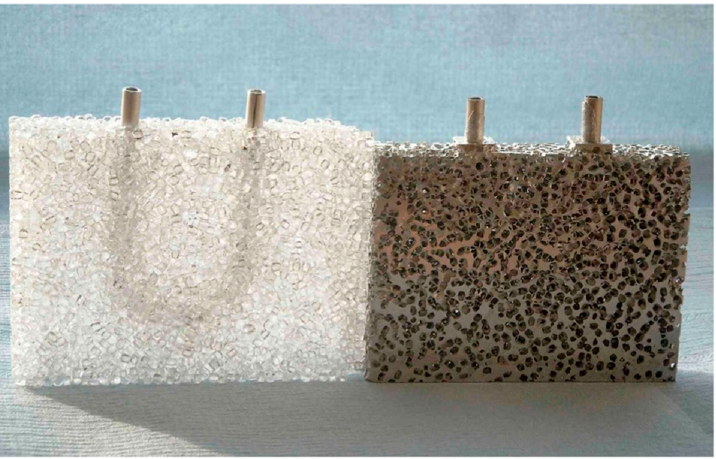
Figure 5. Use of supporting foams utilized for PCM investigations, including pass-through tubing for working fluid thermal exchange [52].